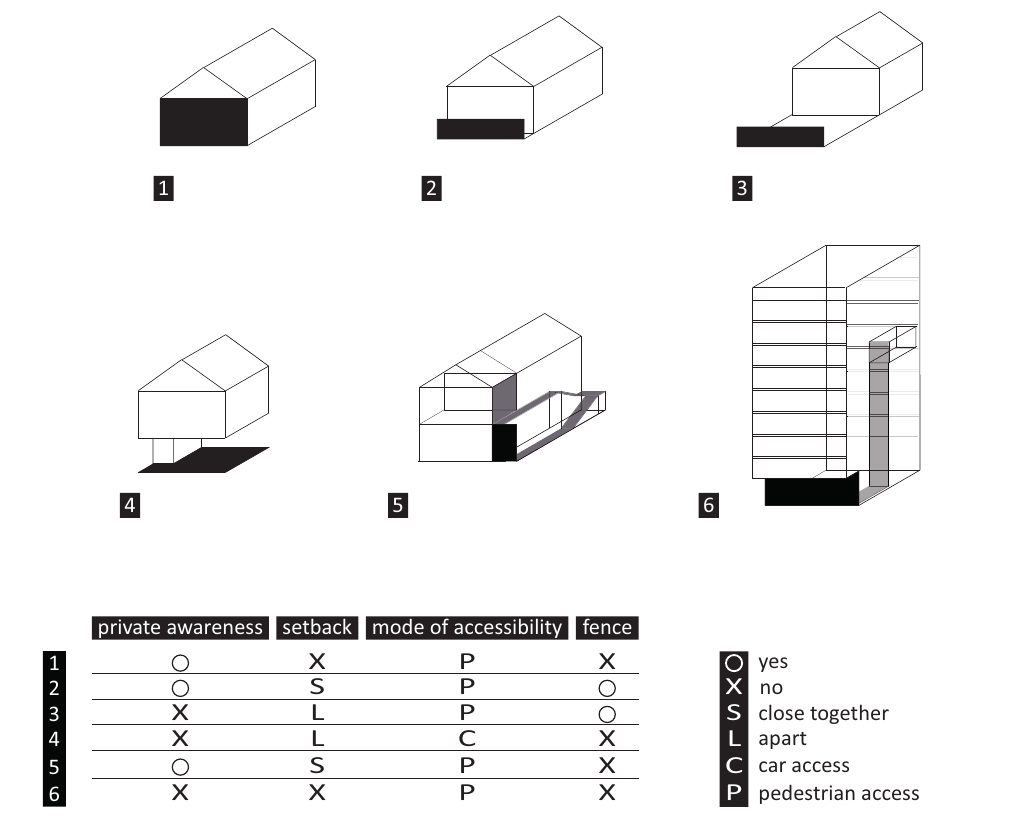
Figure 1. Patterns of the public‐private interface in